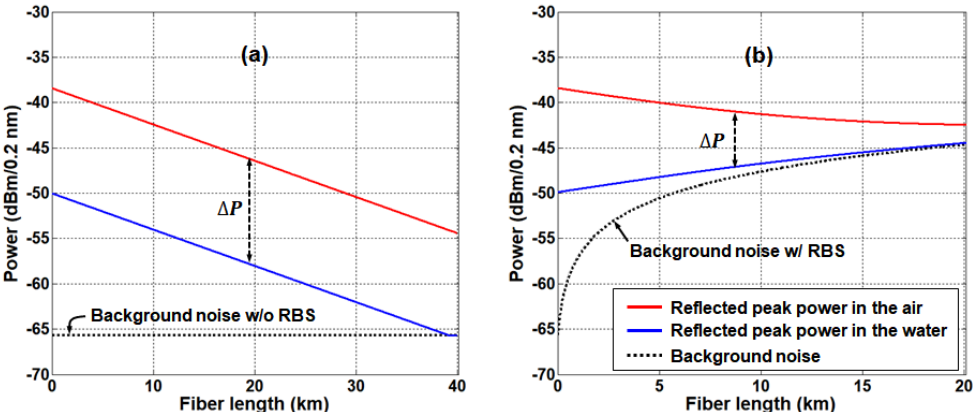
Figure 3. Peak power evolution of each received optical signal reflected in the air and water according to the transmission length ( a ) without the RBS effect ( b ) with the RBS